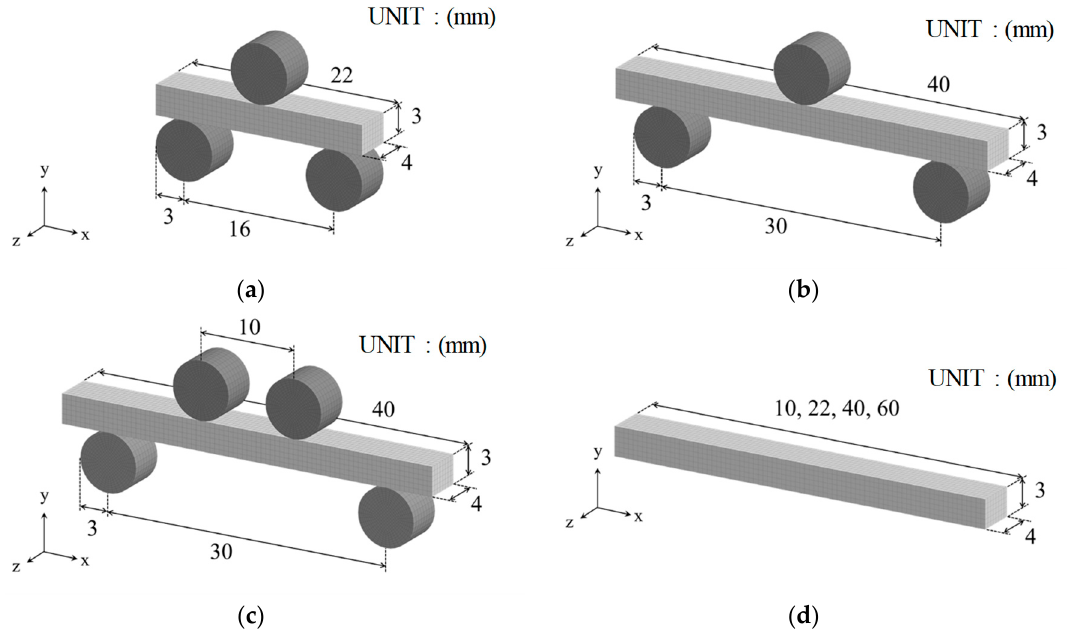
Figure 3. FE models: ( a ) three-point bending Test A (span is 16 mm); ( b ) three-point bending Test B (span is 30 mm); ( c ) four-point bending test; ( d ) tensile test.